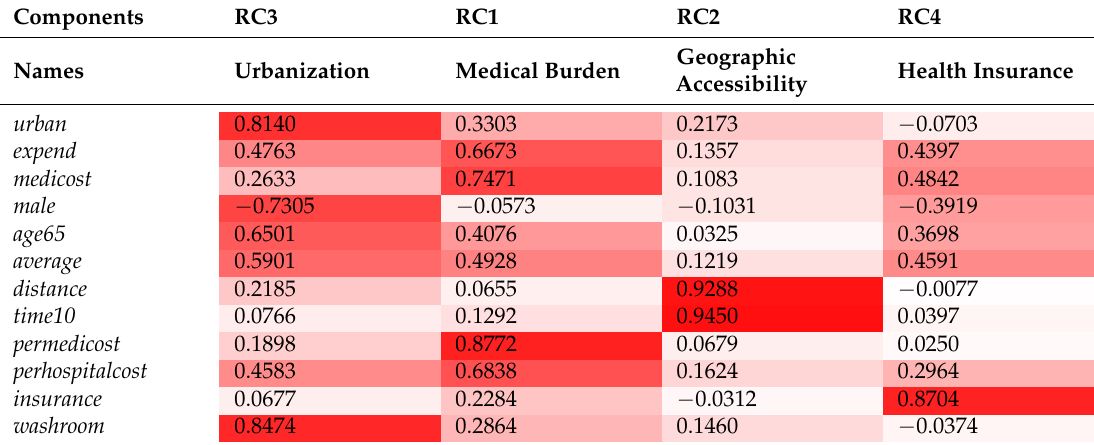
Table A4. Component loadings ( illnessday / chronicratio ).